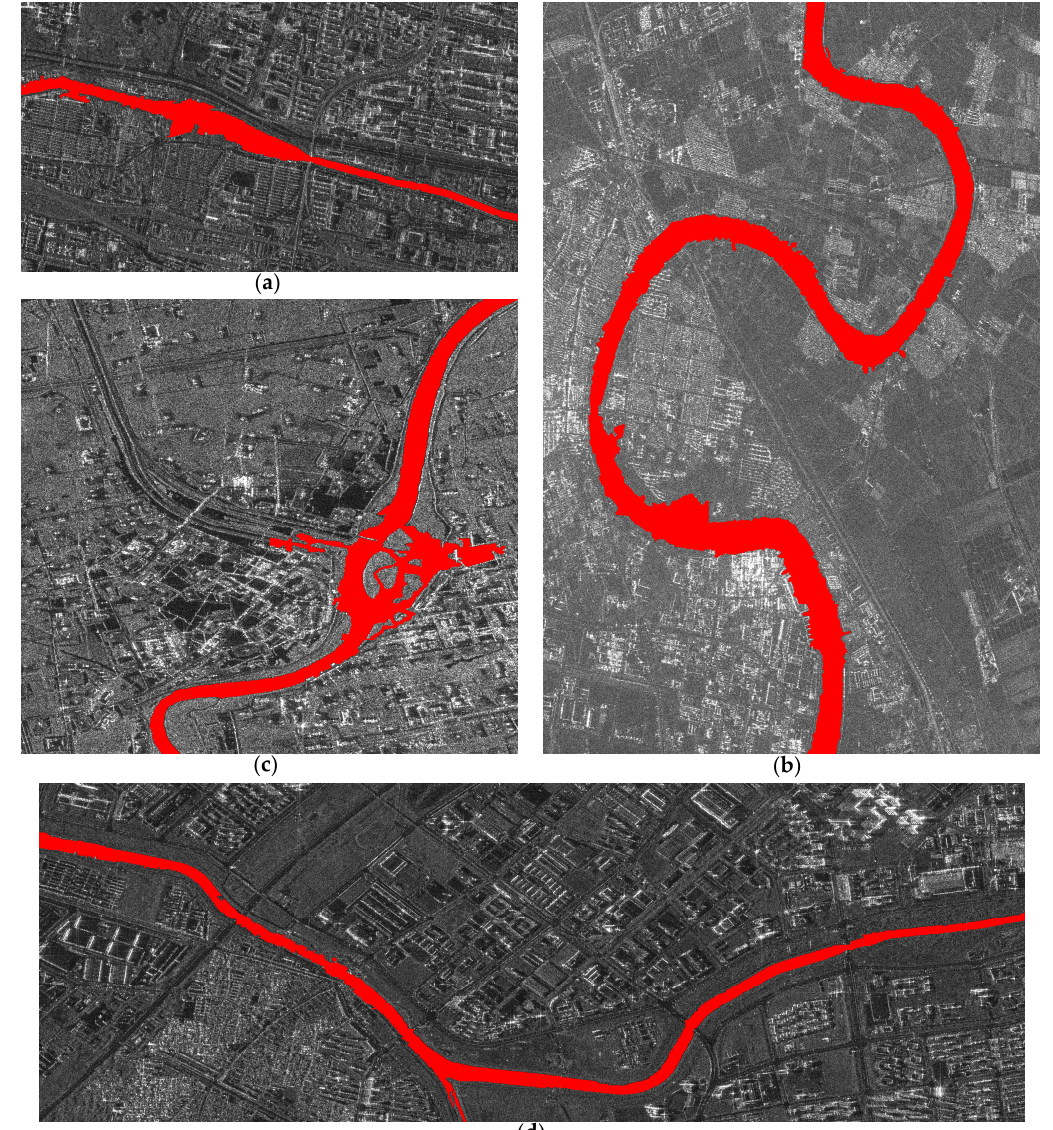
Figure 17. Riverway extraction results and its qualitative evaluation. ( a ) 1100 × 1800; ( b ) 3000 × 1950; ( c ) 1400 × 1000, and ( d ) 1550 × 2950 pixels.